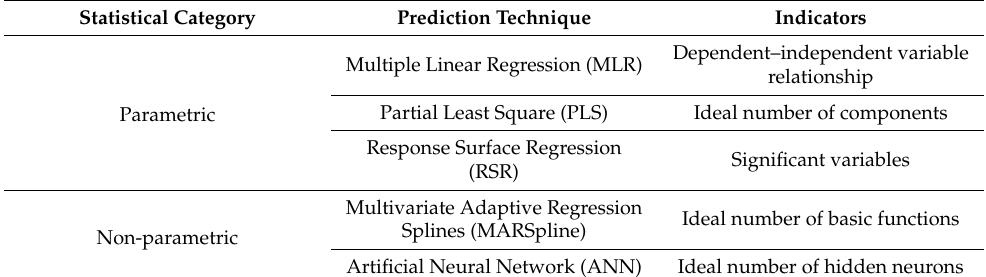
Table 1. Prediction techniques evaluation indicators for the OQMM